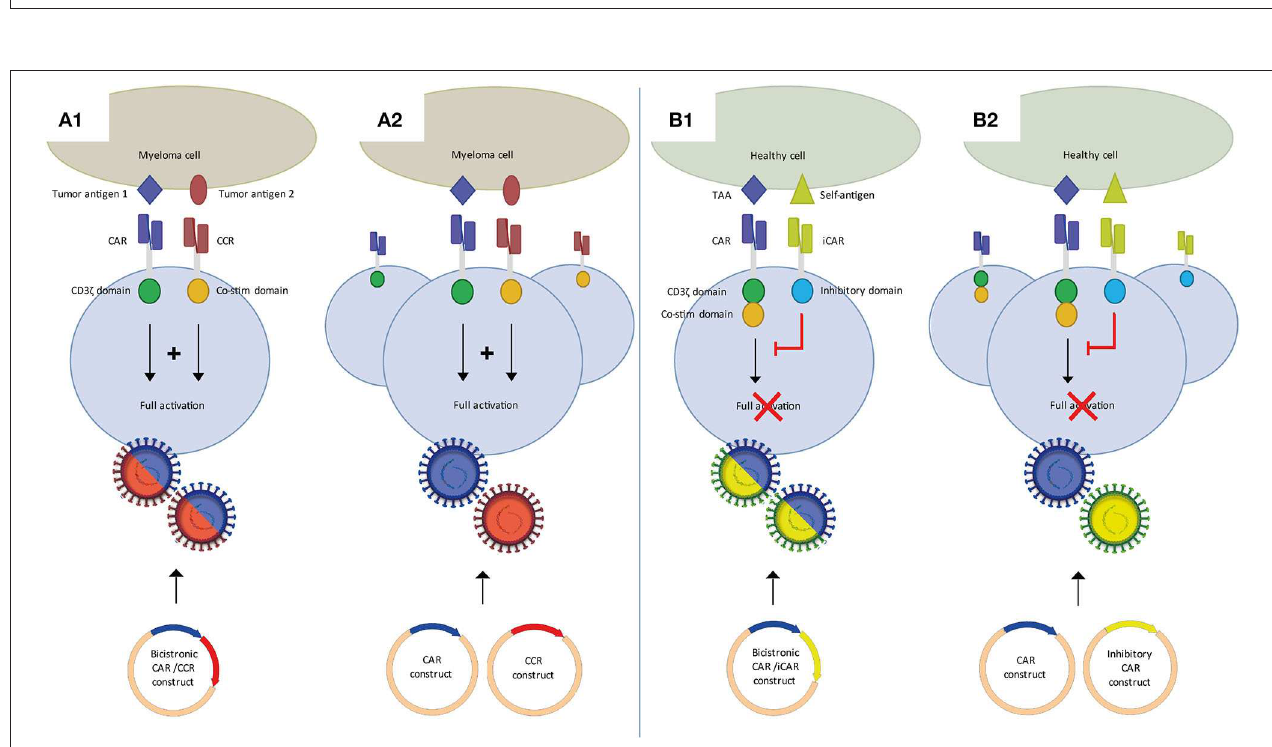
FIGURE 2 | Dual CAR strategies to improve specificity of CAR T-cell MM therapy. (A) Split CAR T-cells, in which activation through CD3 ζ and co-stimulation are split over a first generation CAR and a chimeric co-stimulatory CAR (CCR), each targeting distinct tumor antigens. Binding of both CARs is required for full T-cell activation. Split CAR T-cells can be generated using a bicistronic vector (A1) or two separate CAR and CCR vectors (A2) . (B) An inhibitory CAR (iCAR) binding a self-antigen inhibits T-cell activation of a second CAR targeting a tumor-associated antigen (TAA). In the absence of a self-antigen it functions as a conventional single CAR T-cell. CAR/iCAR combinations can also be made using a bicistronic vector (B1) or two separate CAR and iCAR vectors (B2) .